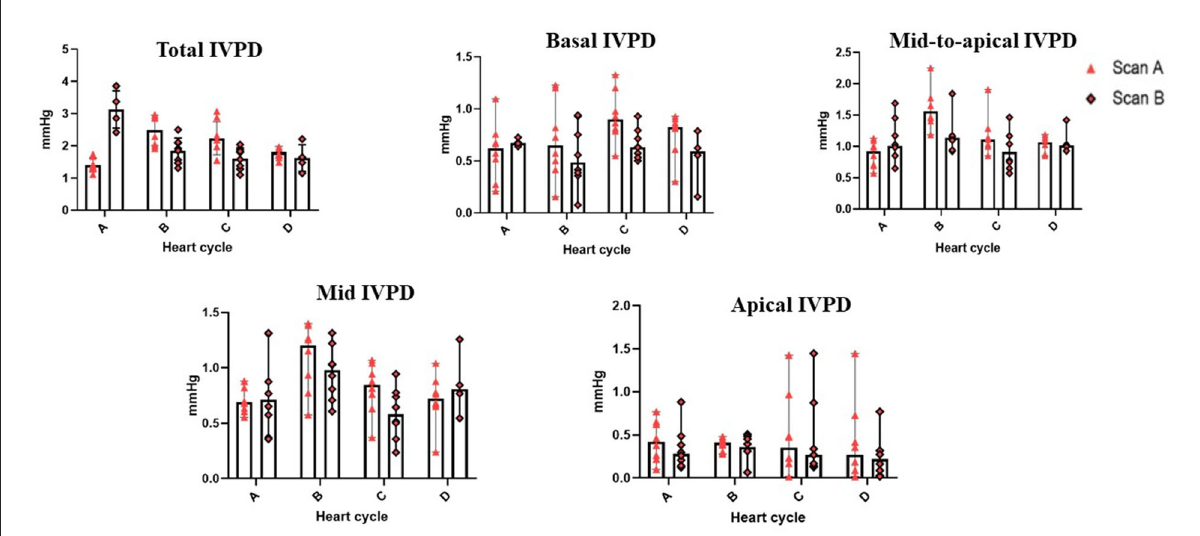
FIGURE2 Variability of CMME-derived intraventricular pressure difference (IVPD). Variability was calculated within goats between heart cycles (four heart cycles were selected) and between time by two observers (scans A and B); n = 8.